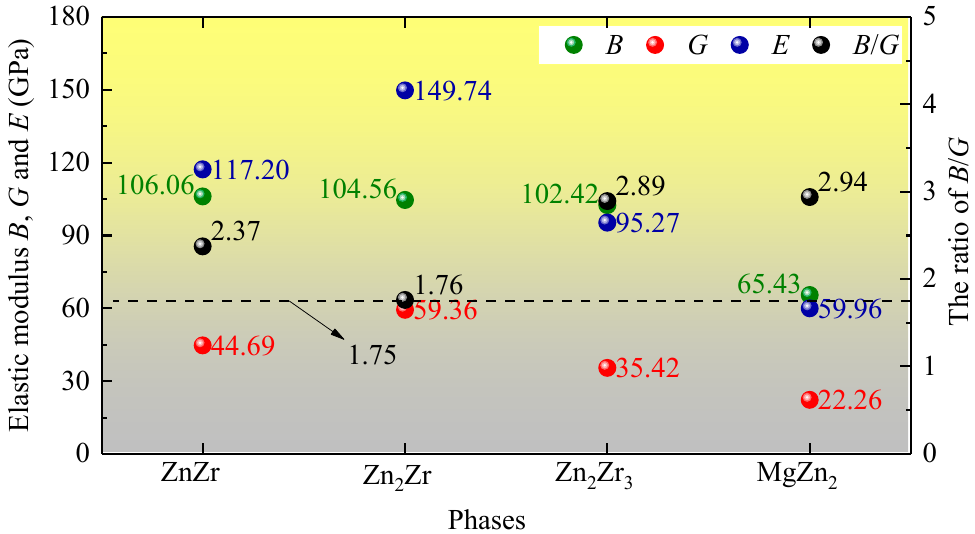
Figure 2. Calculated mechanical properties, including bulk modulus B , shear modulus G , and Young’s modulus E , as well as B / G values for ZnZr, Zn 2 Zr, Zn 2 Zr 3 , and MgZn 2 .